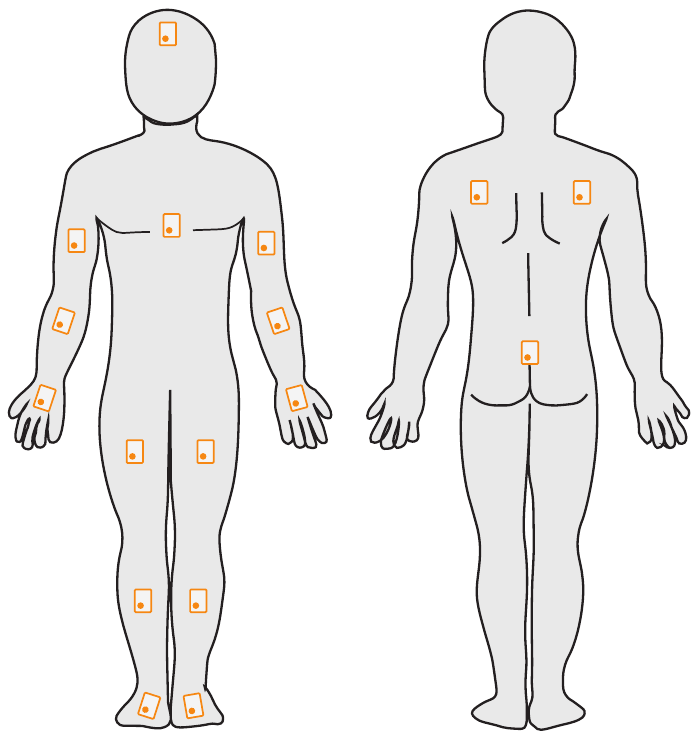
Figure 2. Positioning of the IMUs (orange outline) on the